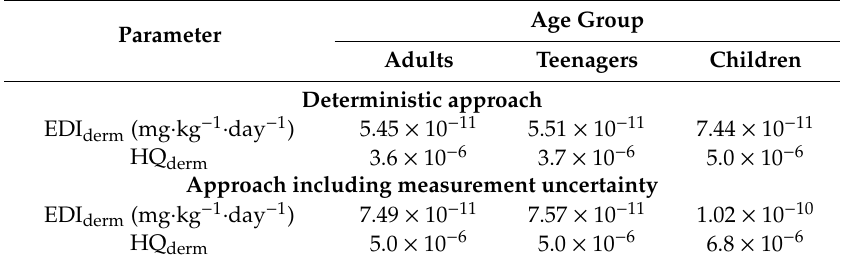
Table 4. The results of health risk